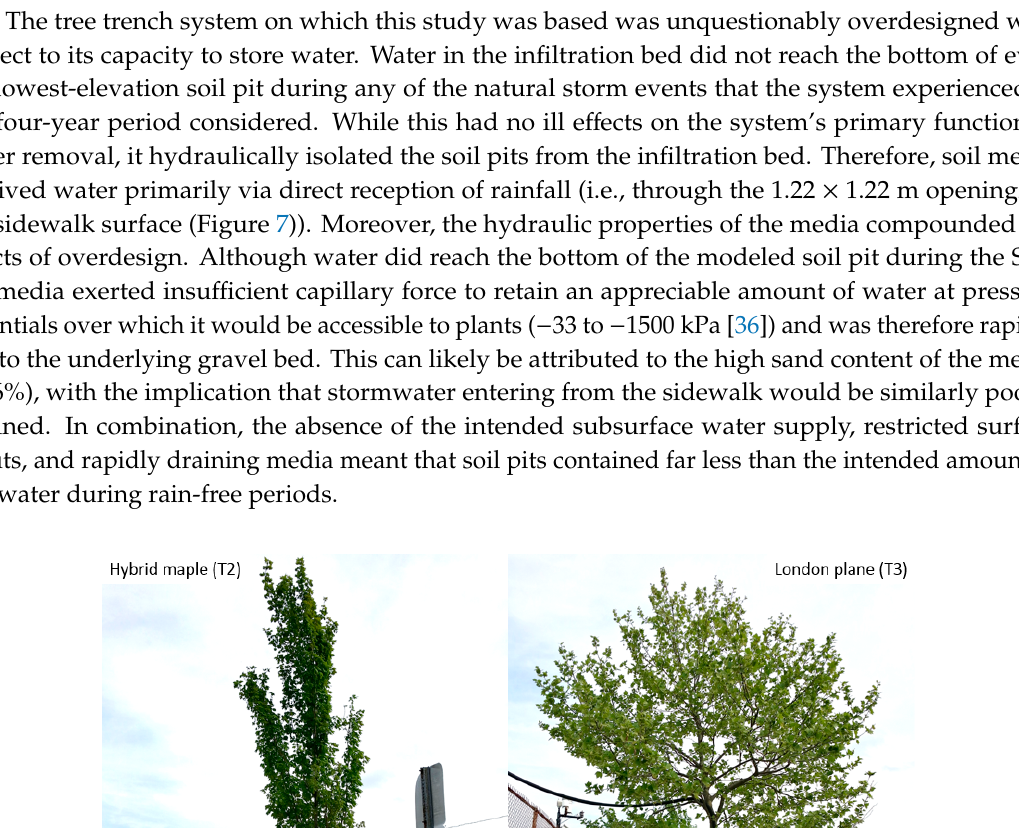
Figure 8. Root penetration into the distribution pipe during subsurface cleaning in June 2016. 4.2. Implications for Design Ideally, vegetated GI systems would be deliberately designed to minimize plant water stress while still meeting stormwater management goals. This is likely to be less difficult in cases where vegetation is smaller in stature and therefore has lower water requirements than do trees, though trees are preferred in many settings given their aesthetic and ability to provide services like shade [42]. Trees’ rates of water use are also typically greater than those of smaller-stature plants [19,43], enhancing their utility in GI. In designing GI systems for which trees are desired but their soil pits are at risk of hydraulic isolation (notably, tree trenches), the results of this study suggest that several modifications to typical designs could help to minimize the frequency and intensity of water stress events. First, designers should restrict overdesign so that water captured in infiltration beds during small to moderate storms thoroughly wets the soil provided to plants. In most cases, achieving an appropriate distribution of water depths over time would entail carefully optimizing design parameters (notably catchment depth); this might include accounting for exfiltration from the gravel bed during storms rather than using a static sizing approach. Such efforts may be particularly important when the infiltration capacity of the native soil is moderate or greater (such as with the